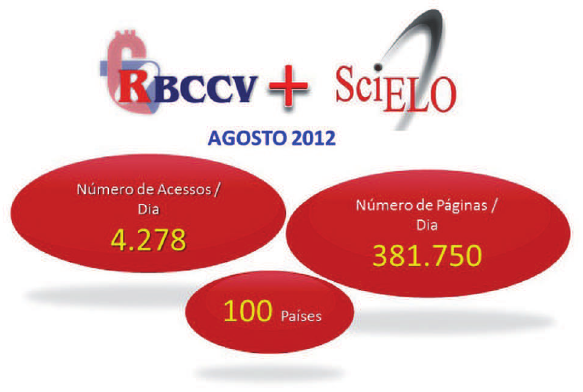
Fig. 2 - Acessos aos sites da RBCCV/BJCVS em agosto de 2012